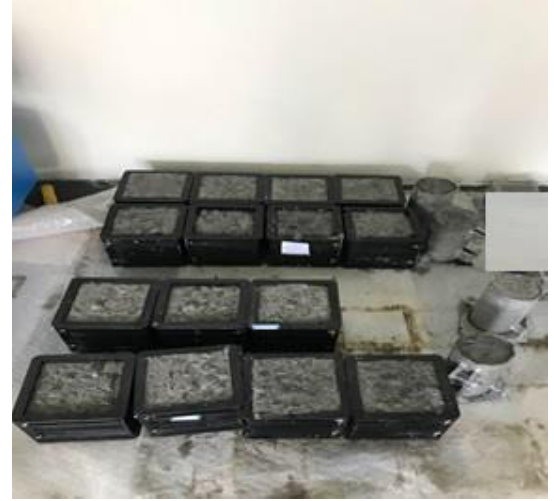
Figure 4 . Sample construction with rice husk ash and microsilica